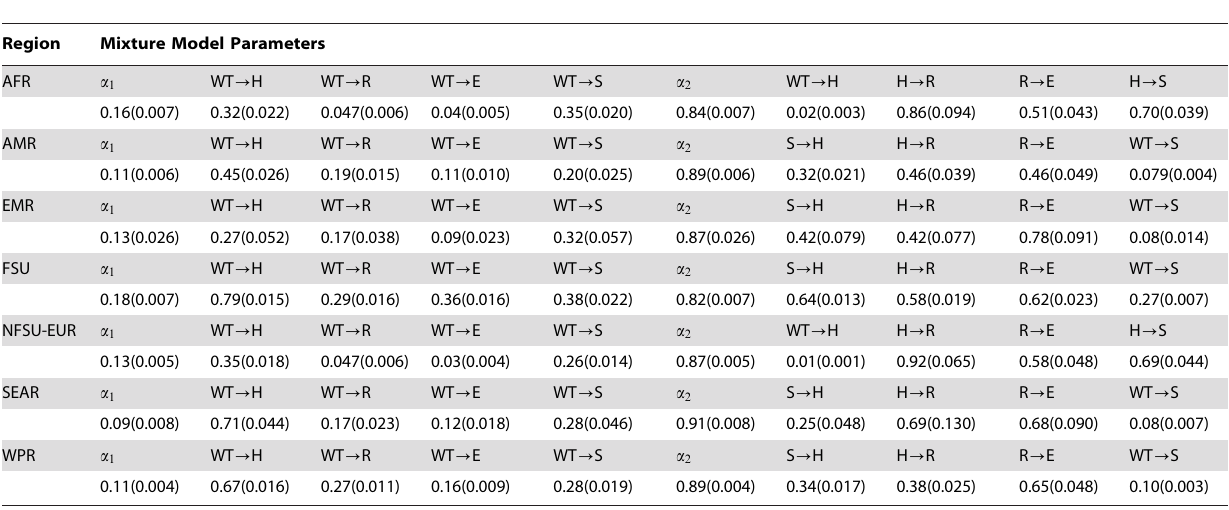
Table 2. Posterior nodes and standard deviations of mixture model parameters describing resistance in treatment-naı¨ve patients.